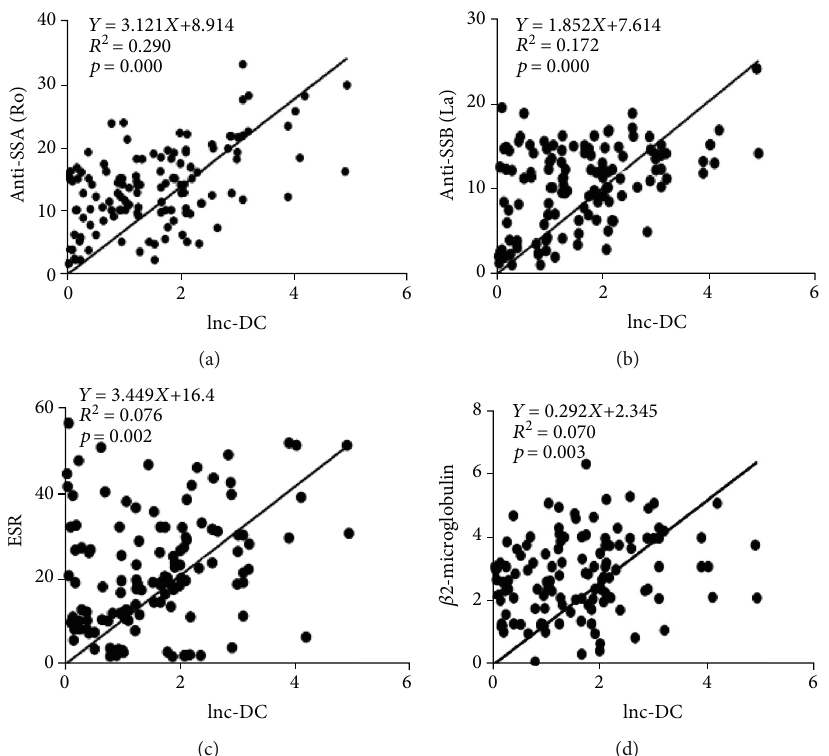
Figure 2: lnc-DC and the correlativity of pSS patients with certain clinical characteristics, lnc-DC, and 127 patients with pSS in the correlation between some clinical characteristics, including anti-SSA (a), anti-SSB (b), the ESR (c), and β used the Spearman rank correlation coe ffi cient